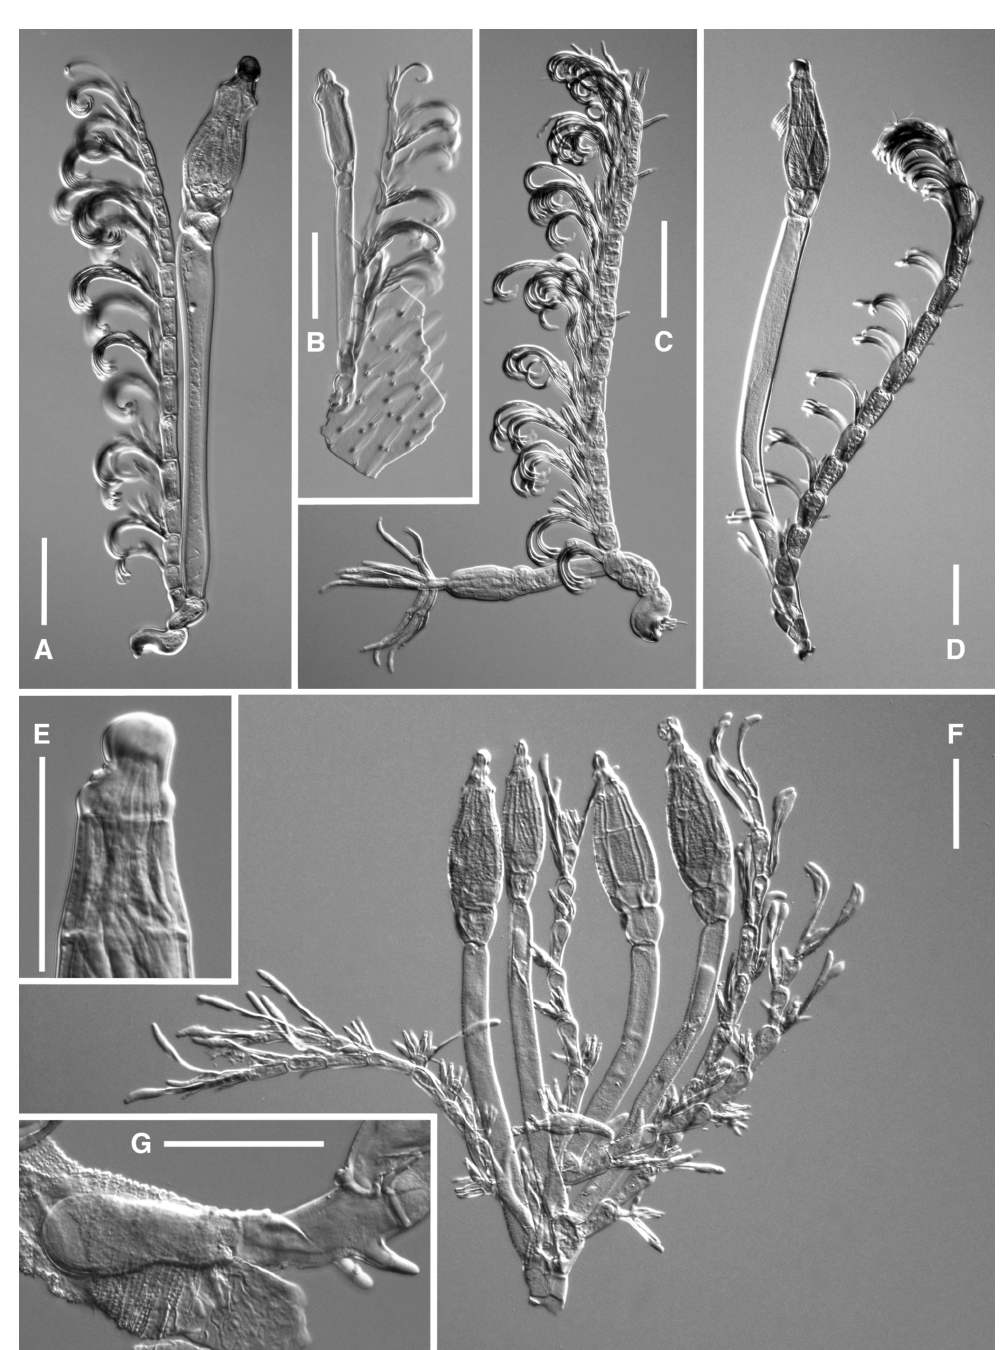
Fig. 1. Photomicrographs of the new species of Rhizomyces Thaxt.: A . R. forcipatus W.Rossi & Feijen sp. nov. (FI 4100a). B . Thallus of R. forcipatus sp. nov. from the wing of Teloglabrus sp. (FI 4125). C . Immature thallus of R. forcipatus sp. nov. showing the trichogyne and the basal cell holding firmly a piece of the exoskeleton of the host insect (FI 4099). D . R. tschirnhausii W.Rossi & Feijen sp. nov. (FI 4091). E . Upper portion of the perithecium of R. tschirnhausii sp. nov. (FI 4090). F . R. ramosus W.Rossi & Feijen sp. nov. (FI 4201a), amid the four mature perithecia, near the base of the stalk cells, it can be seen a fifth very immature perithecium bearing the trichogyne. G . R. ramosus sp. nov. (FI 4201a), the pyriform haustorium with remains of the host integument and cell I showing two primordia of new branches. Scale bars: 50